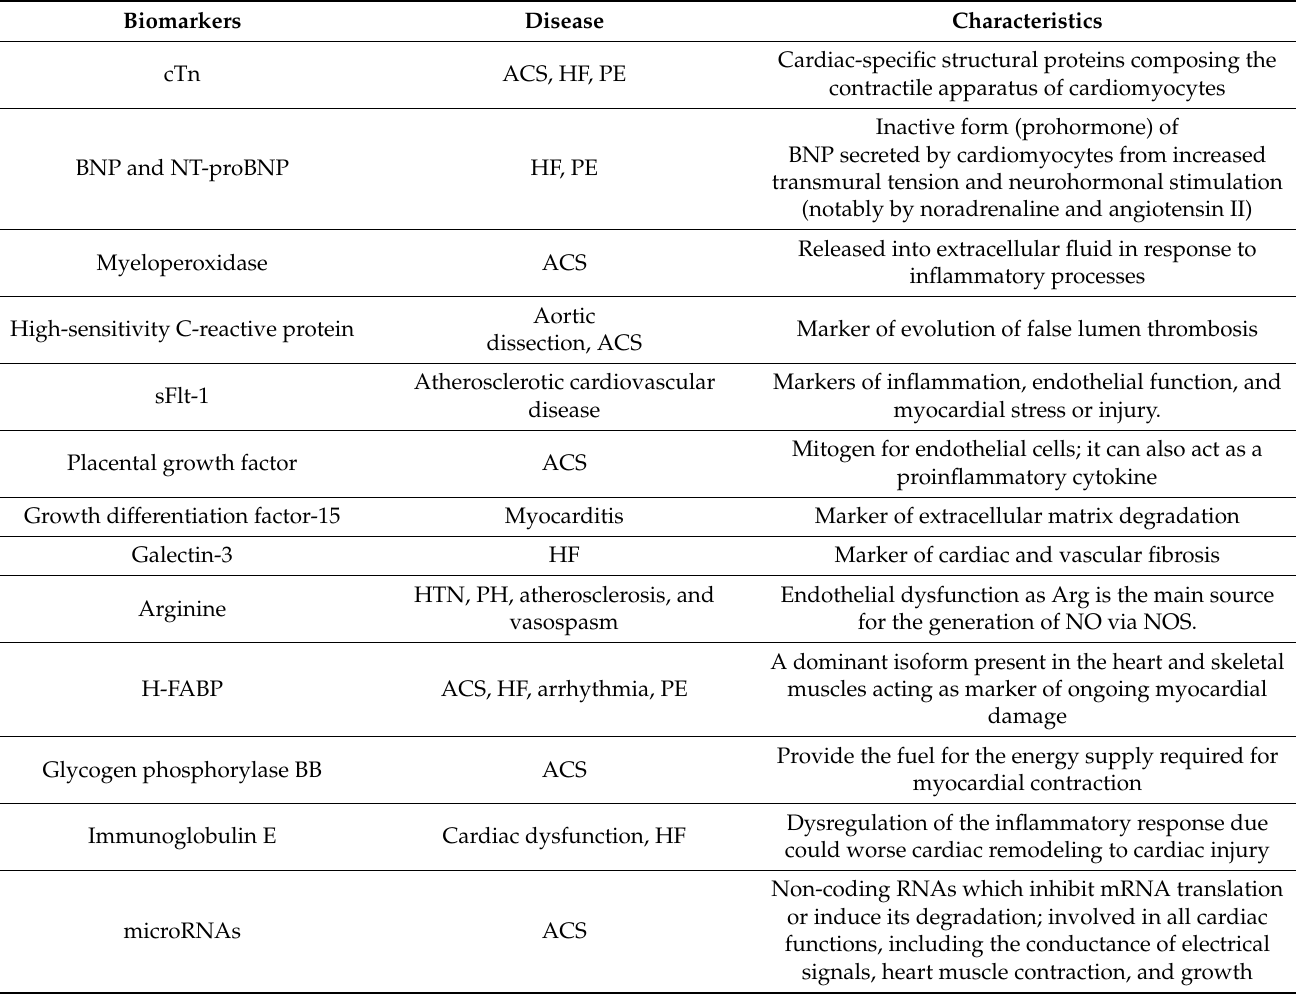
Table 2. Comparison of main characteristics of biomarkers potentially employed in cardiotoxicity de-